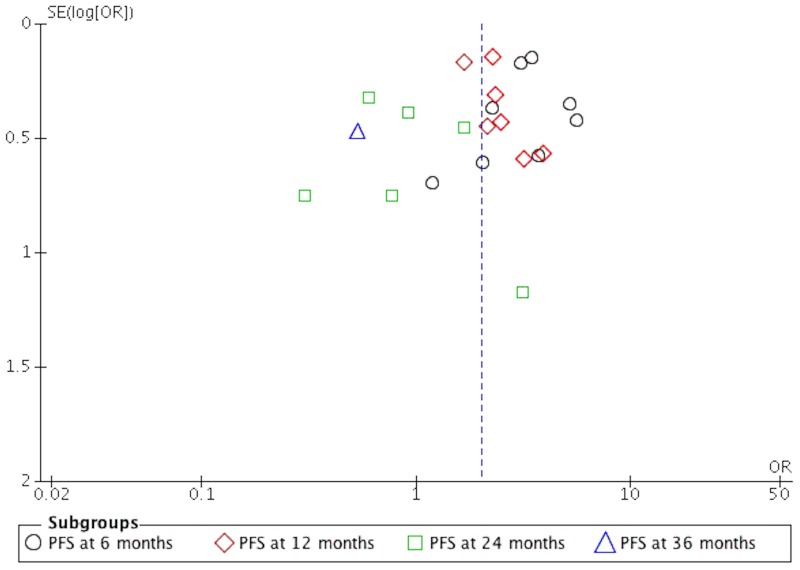
The funnel plot of PFS on patients with newly diagnosed GB.